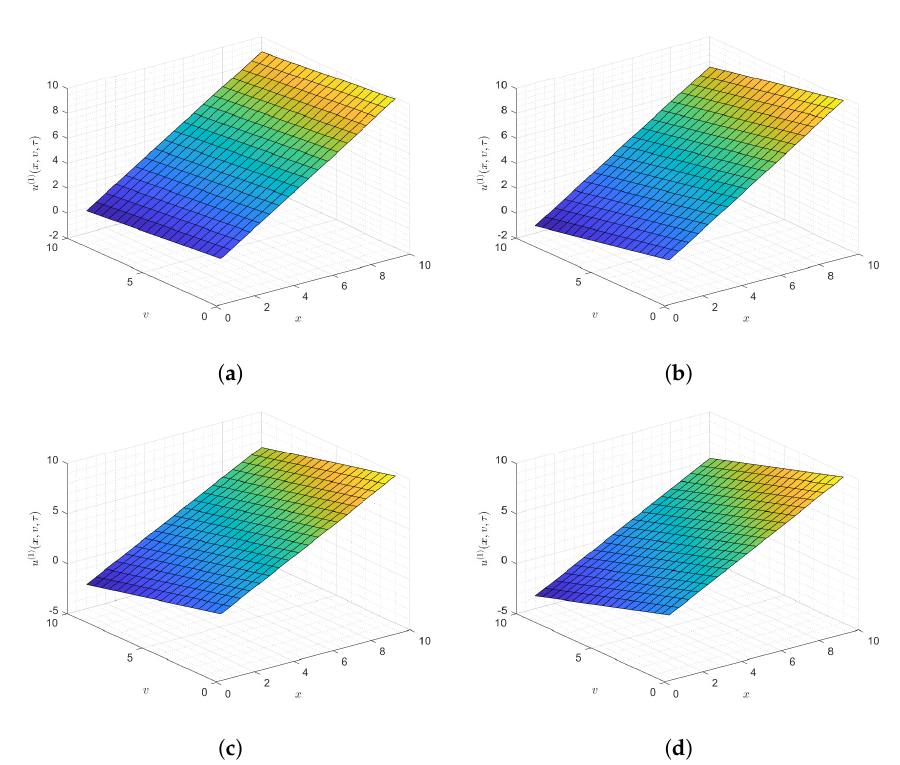
Figure 4. Surface plots of the first conditional moment u ( 1 ) ( x , v , τ ) by varying x , v ∈ [ 1,10 ] at different values of τ . ( a ) u ( 1 ) ( x , v ,0.25 ) . ( b ) u ( 1 ) ( x , v ,0.5 ) . ( c ) u ( 1 ) ( x , v ,0.75 ) . ( d ) u ( 1 ) ( x , v ,1 ) .